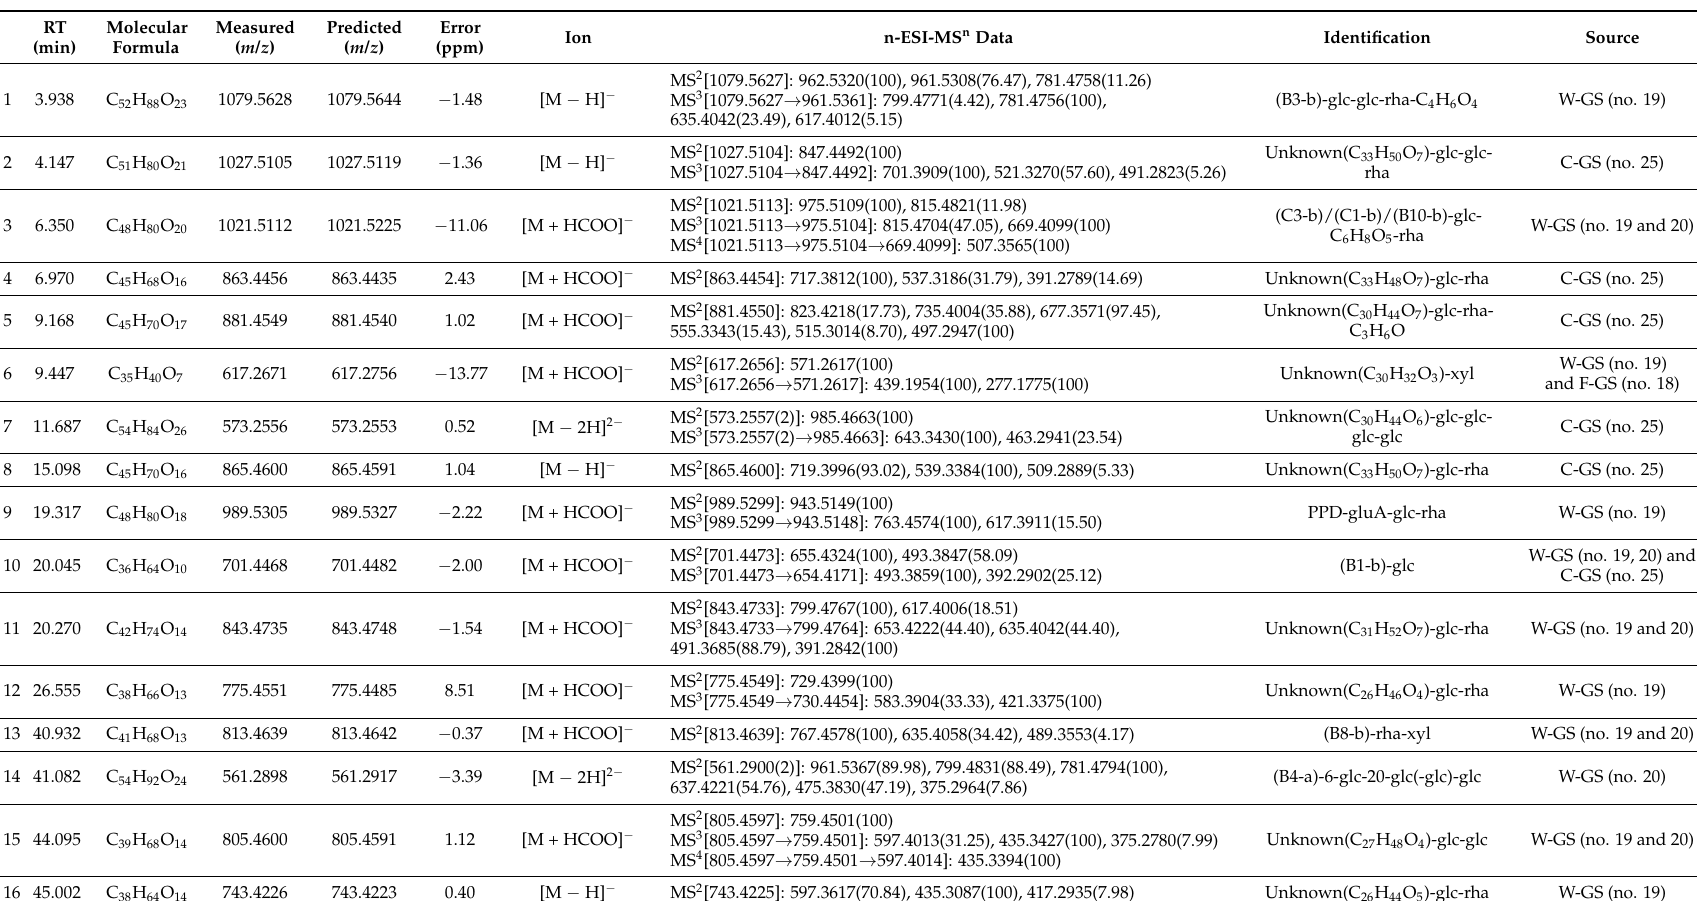
Table 2. Sixteen potential new compounds tentatively identified from wild ginseng (W-GS), ginseng under forest (F-GS), and cultivated ginseng (C-GS) via HPLC-IT-TOF-MS n